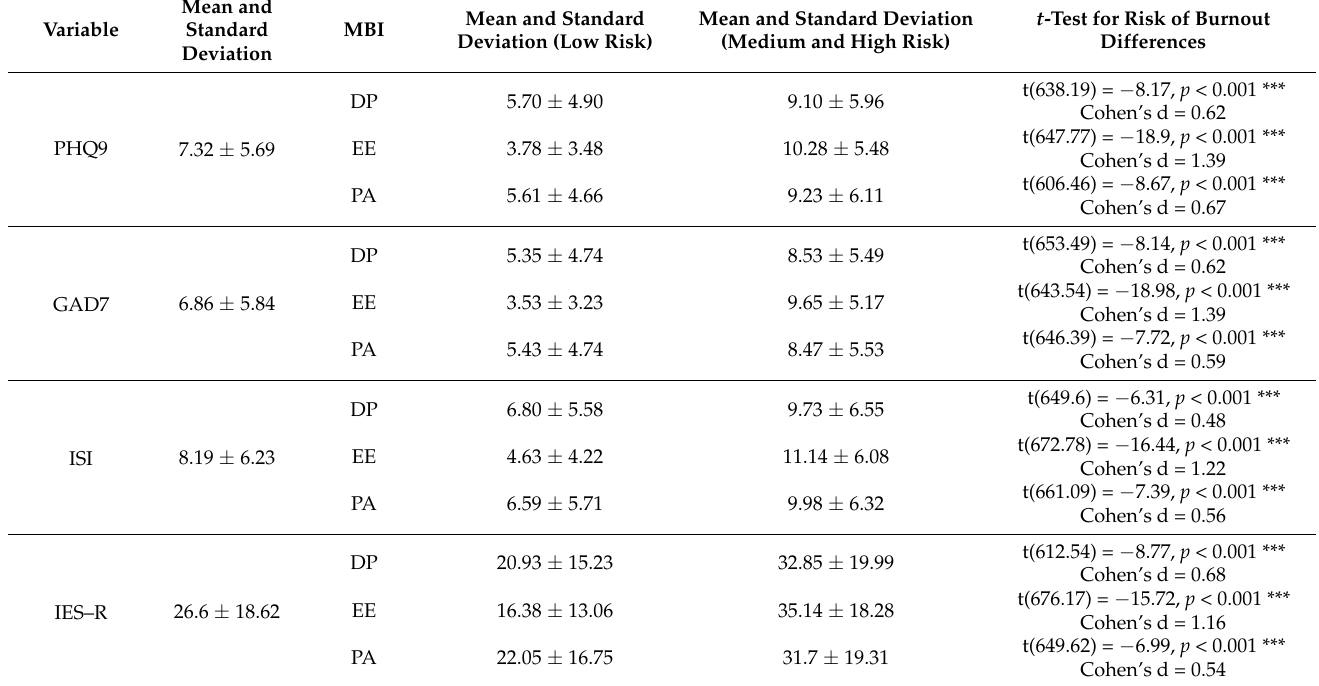
Table 3. Descriptive statistics for measured variables and t-tests for burnout